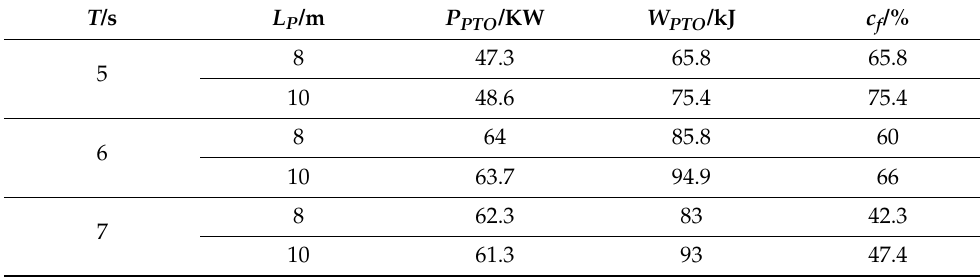
Table 2. Different flapping-panel length efficiency Table 1. Wave energy conversion efficiency.